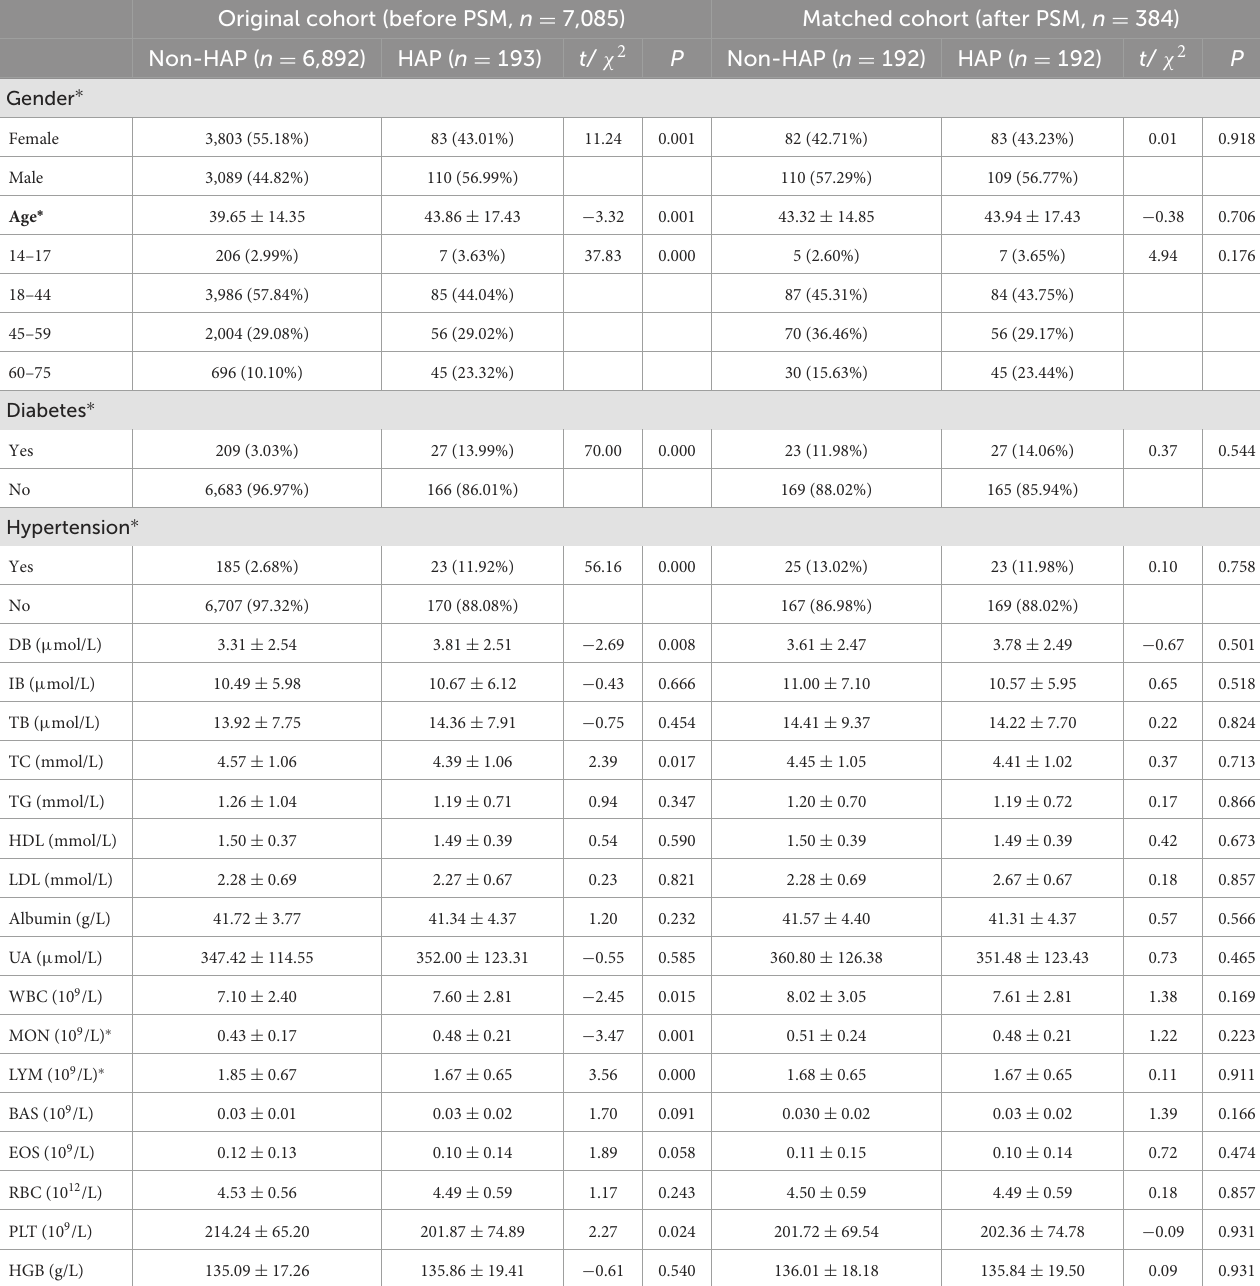
TABLE 1 Personal characteristics of patients with schizophrenia with and without HAP (before and after